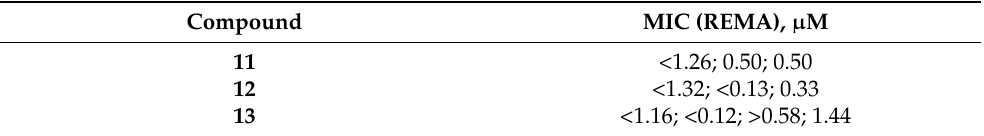
Table 2. Results of replicated REMA experiments for MIC testing of three more efficient